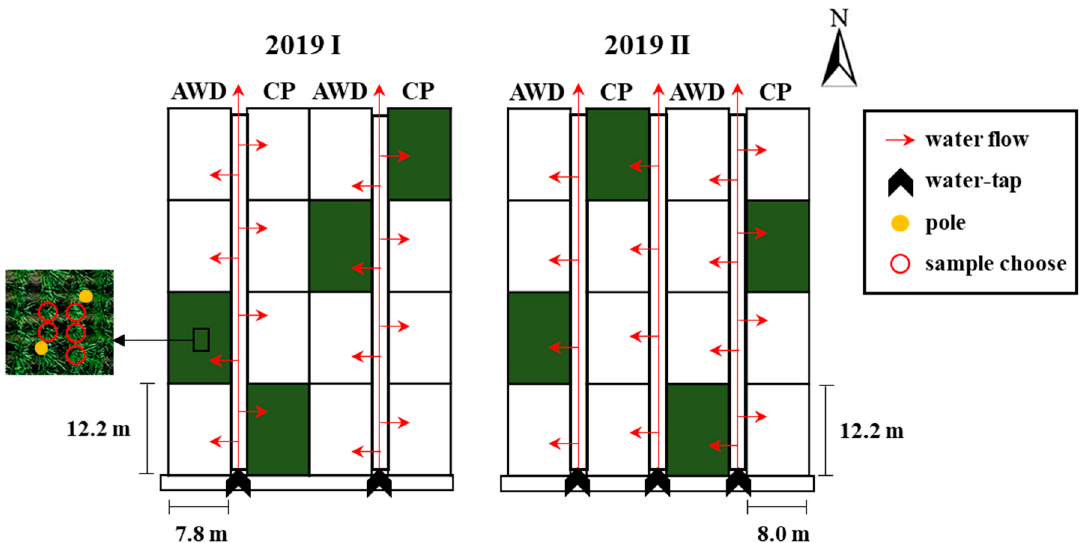
Figure 2. Schematic diagram of water treatment in the test field, Taiwan Agricultural Research Institute, Council of Agriculture. Green areas are experimental rice paddies in this study.